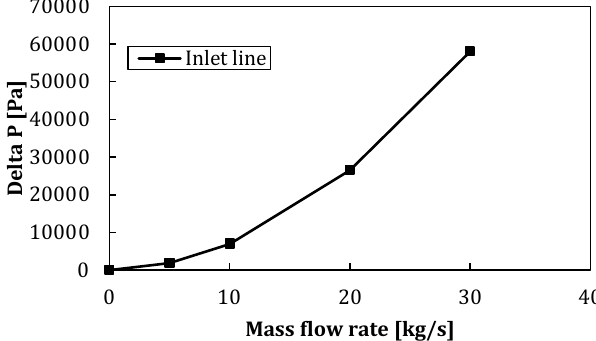
Figure 4. Inlet pipe pressure drop Vs mass flow characteristic. The points of the curve were simulated by means of a separated steady-state CFD analysis of the inlet pipe only.